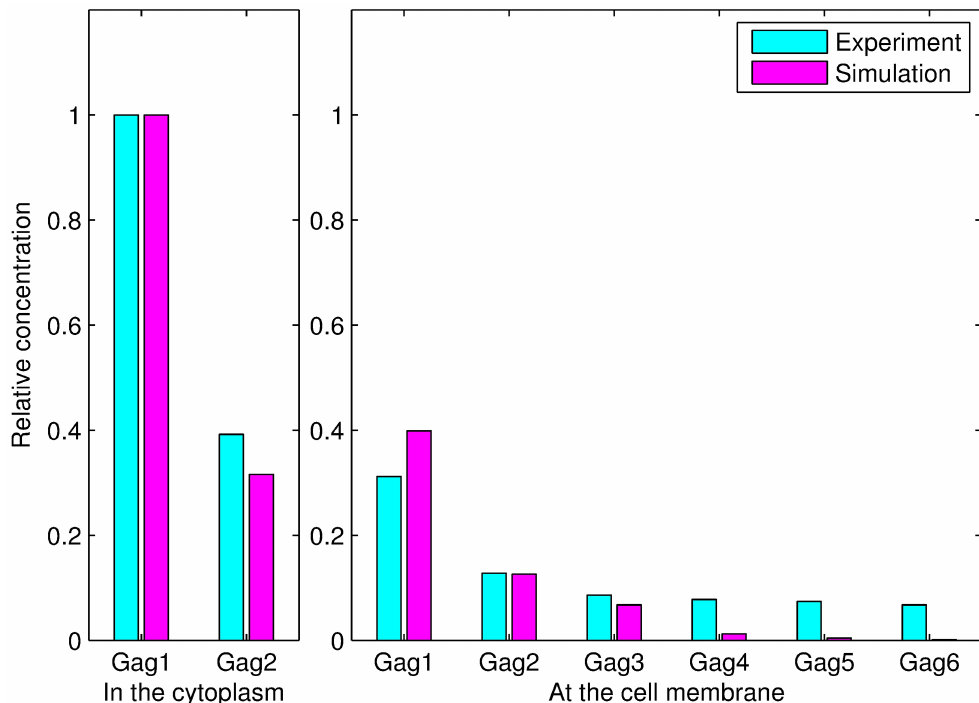
Fig 5. Comparison between the simulation results and experimental data for Gag-G2A. Gagi ( i = 1, 2, (cid:1)(cid:1)(cid:1) , 6) denotes a polymerwith i monomers. The left side illustratesthe comparisons betweenthe simulationand experimentally measuredconcentrations for monomers and dimers in the cytoplasm. The right side shows the differencesbetweenthe simulationand experimentally measuredconcentrations with the six types of polymers at the plasma membrane. The concentration of each type of polymer was normalized by dividingby the concentration of Gag monomerin the cytoplasm.